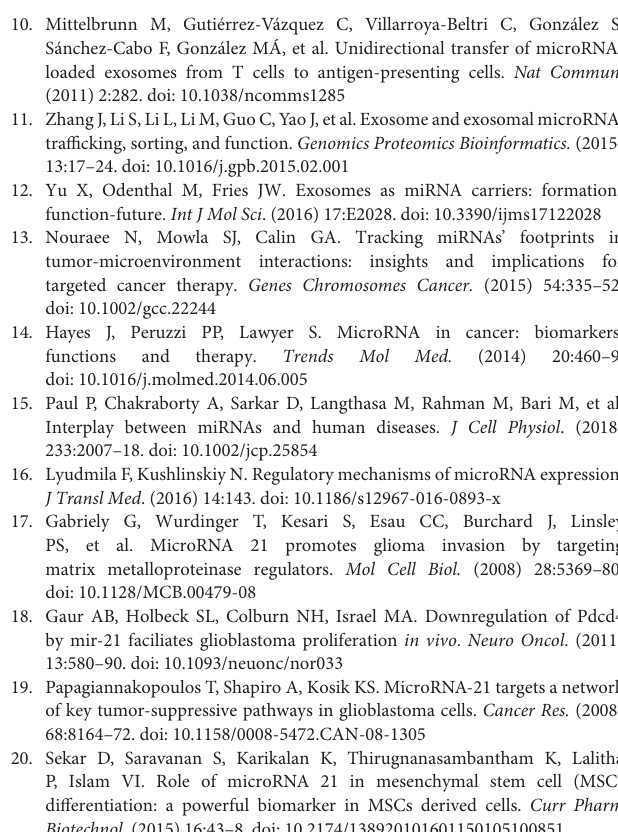
Supplementary Figure 1 | Transfection of pri-miR-21 and miR-21-sponge containing vectors into HEK-293T cells. GFP used as a reporter to visualize transfected cells at 48h (A) and 15 days post-transfection (B) , as well as in stable cells (C) . Supplementary Figure 2 | Characterizing the purity and nature of the extracted exosomes. (A) Our exosome’s size with DLS represented good quality and distribution with a unique size peak under 100nm (66.65nm). (B) Western bloting with special antibodies, anti CD63, and anti CD81, revealed accurate staining of the exosomes membrane special markers and correct negative answer of markers in cell lysate. (C) SEM photos with 4 × 10 4 and 2 × 10 4 indicated particles size between 30 and 170nm, mostly under 100nm. Supplementary Figure 3 | Staining with PKH-26 confirmed exosomes entrance to target cells. Exosomes membrane stained with PKH-26 (showed in red) and Fixation and target cell nucleus, U87-MG, staining with DAPI (showed in blue) was done after 12h, confirmed exosomes entrance to U87-MG target cells. Supplementary Table 1 | Primers and other used